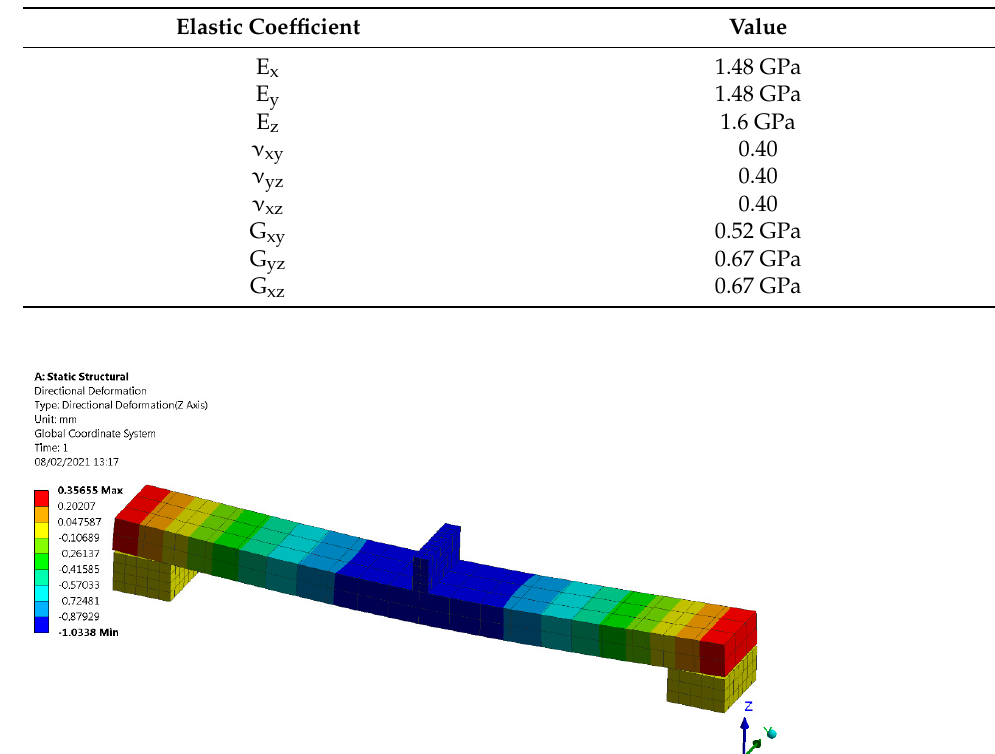
Table 8. Input of the Ansys simulation.